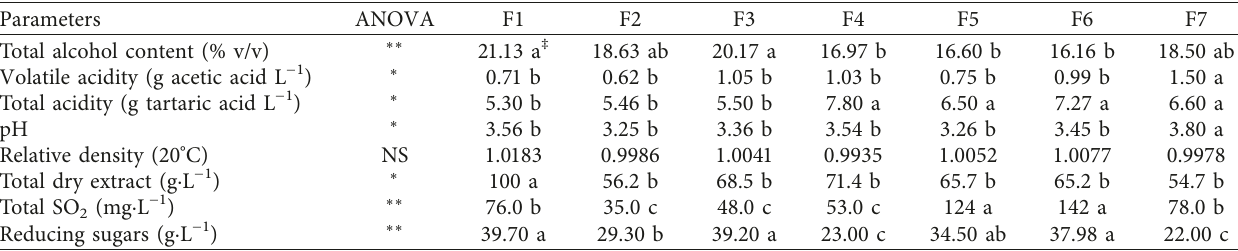
Table 1: Main physicochemical parameters defining the quality of the Fondill´on wine. Parameters